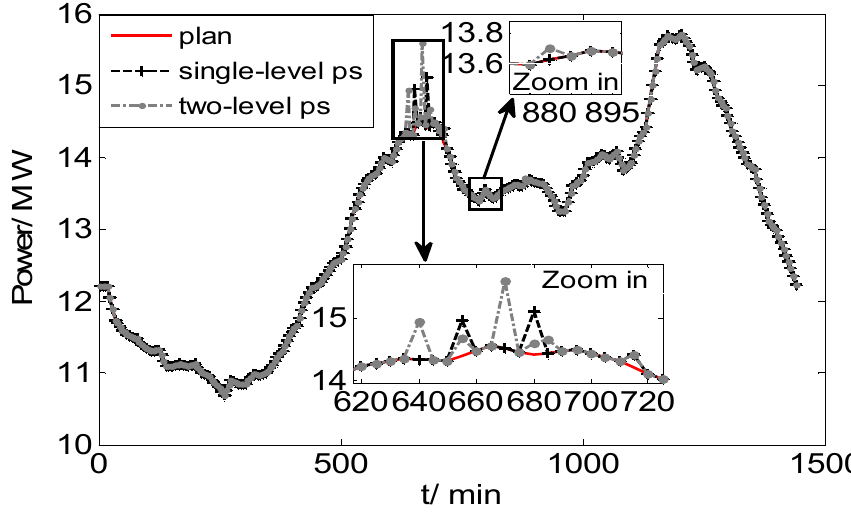
Figure 9. Simulation result for the first